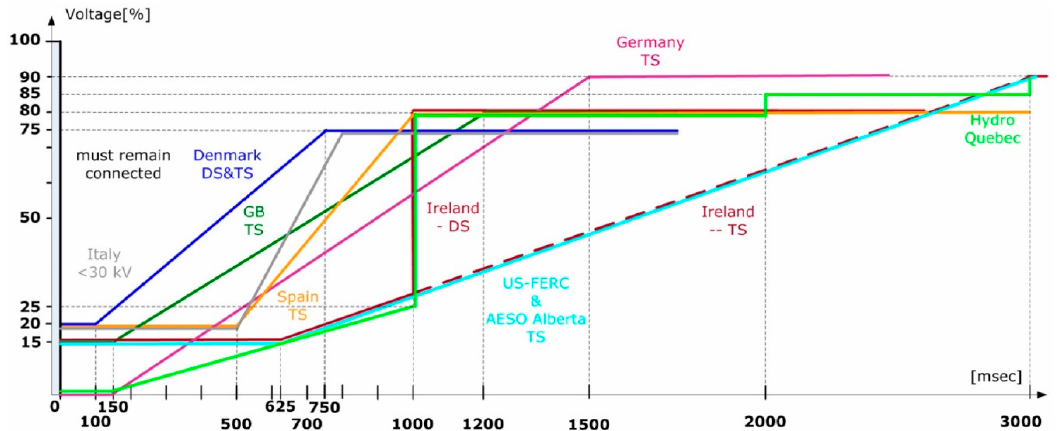
Figure 14. Low-Voltage Ride Through (LVRT) requirements of some grid codes.